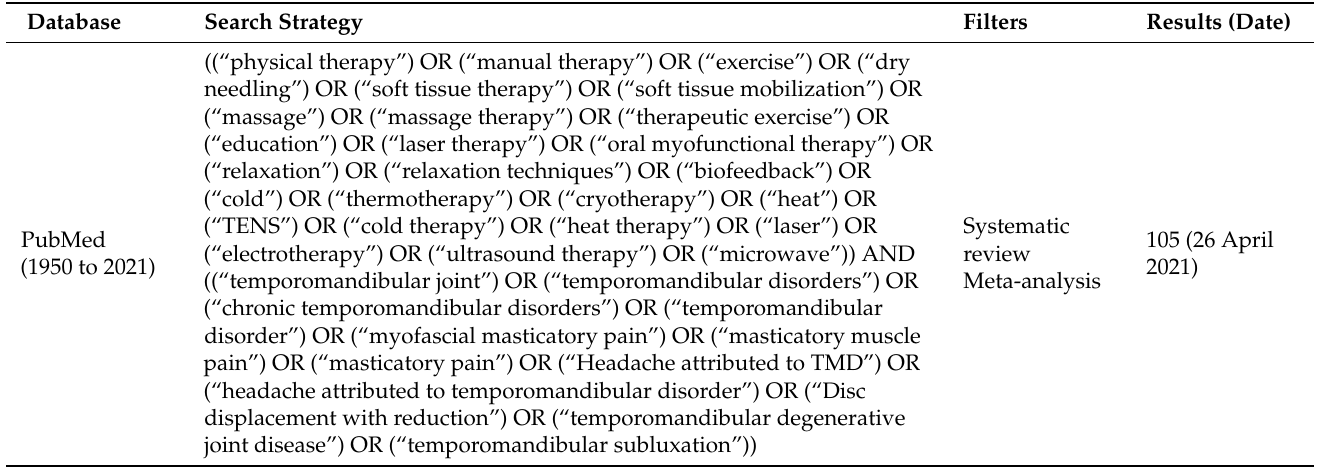
Table A1. Search strategies in each